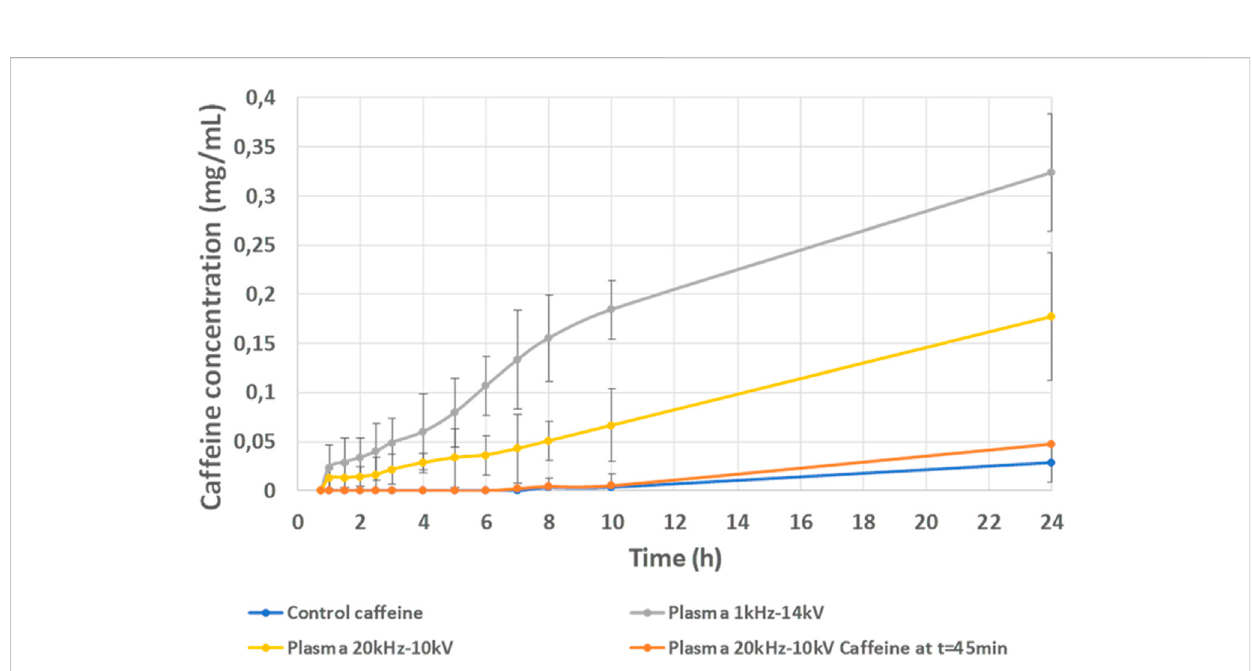
FIGURE 9 24-h evolution of the caffeine concentration measured in the receptor chamber of Franz cells for the blue plot: control, the yellow plot: 20k50s protocol with the caffeine topically applied right after the plasma exposure, the gray plot: 1k100 s protocol with the caffeine topically applied right after the plasma exposure, and the orange plot: 20k50 s protocol but caffeine topically applied with a 45-min delay after plasma